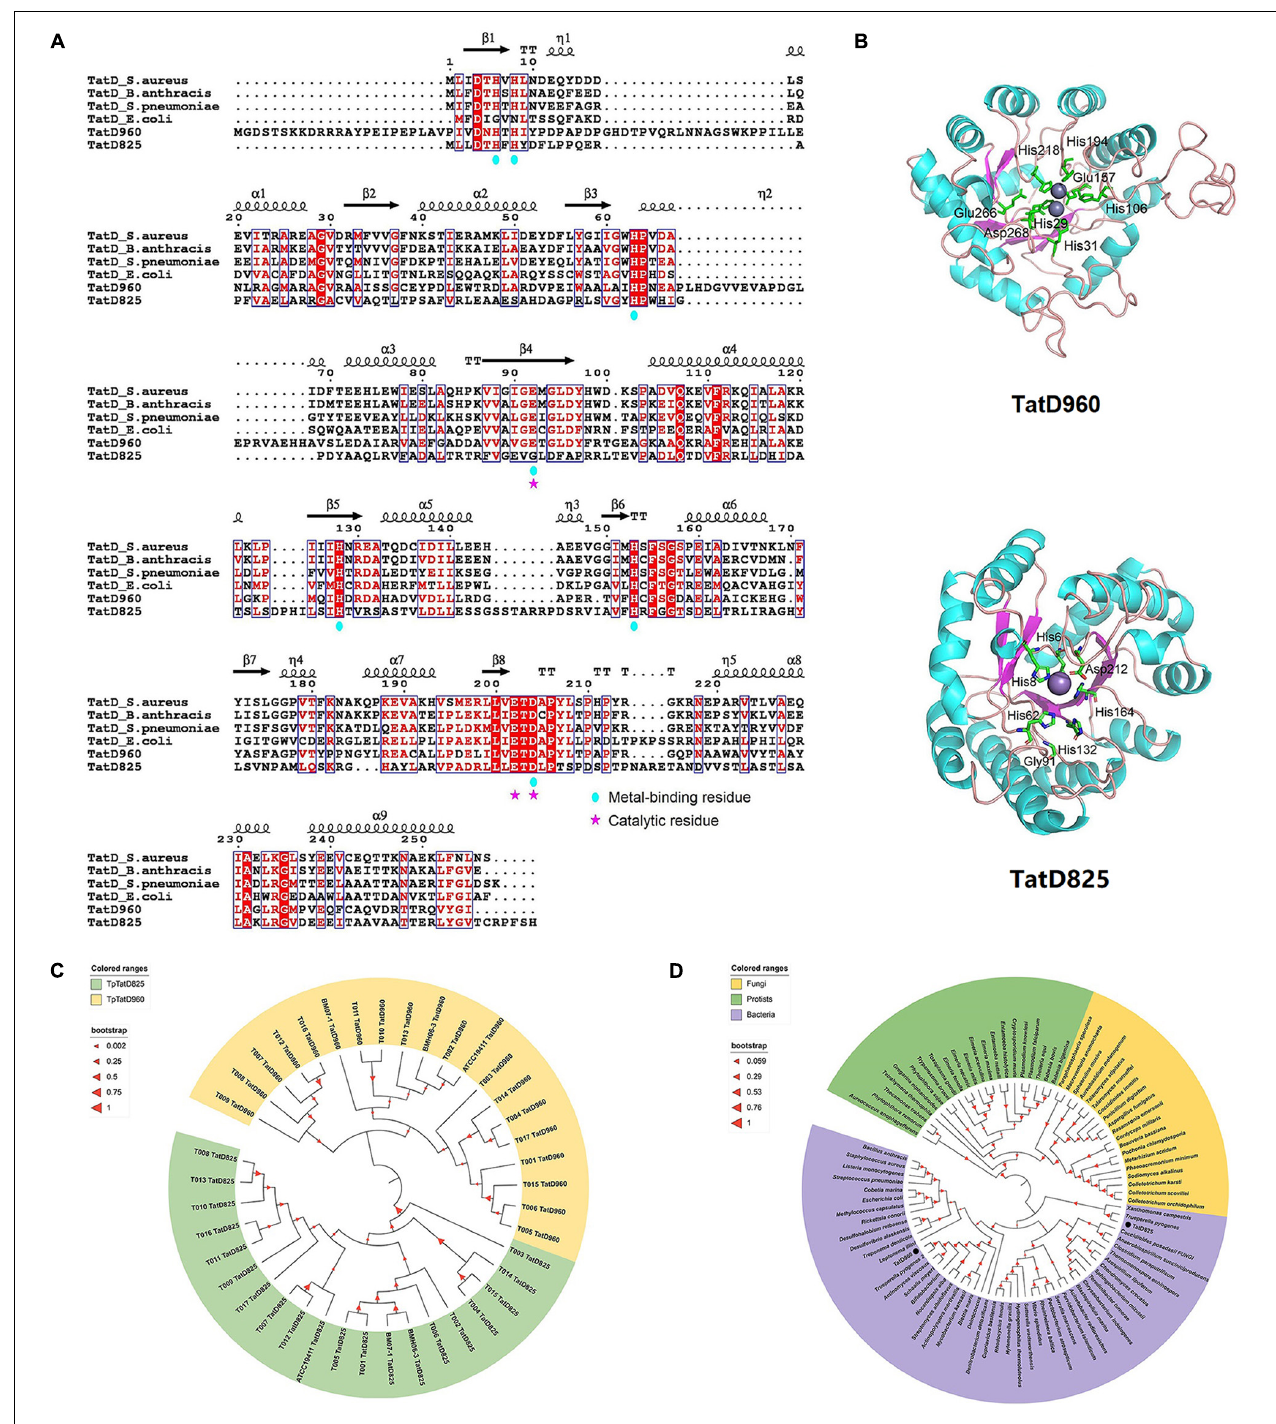
FIGURE 2 | Sequence characteristics and phylogenetic relationships of TatD DNases in T. pyogenes . (A) Amino acid sequence alignment of TpTatDs using ESPript with its homologs of S. aureus , S. pneumoniae , B. anthracis and E. coli . The conserved residues are highlighted in white on a red background. Similar residues are presented in red in blue boxes. The residues contributing to metal binding and catalysis are marked with blue circles and pink stars, respectively. (B) Structural modeling of TpTatDs using SWISS-MODEL. The best match for TatD DNase 960 was found to be with E. coli TatD (PDB ID: 1YIX), and the best match for TatD DNase 825 was E. coli TatD (PDB ID: 3GG7). Metal-binding and catalytic residues in TpTatDs are highlighted in the drawing. (C) Phylogenetic tree of TatD DNase 960 (yellow) and TatD DNase 825 (green) in 20 T. pyogenes . (D) Phylogenetic tree of TatD DNases from bacteria (purple), fungi (yellow) and protists (green). TatD DNases of T. pyogenes are indicated with black